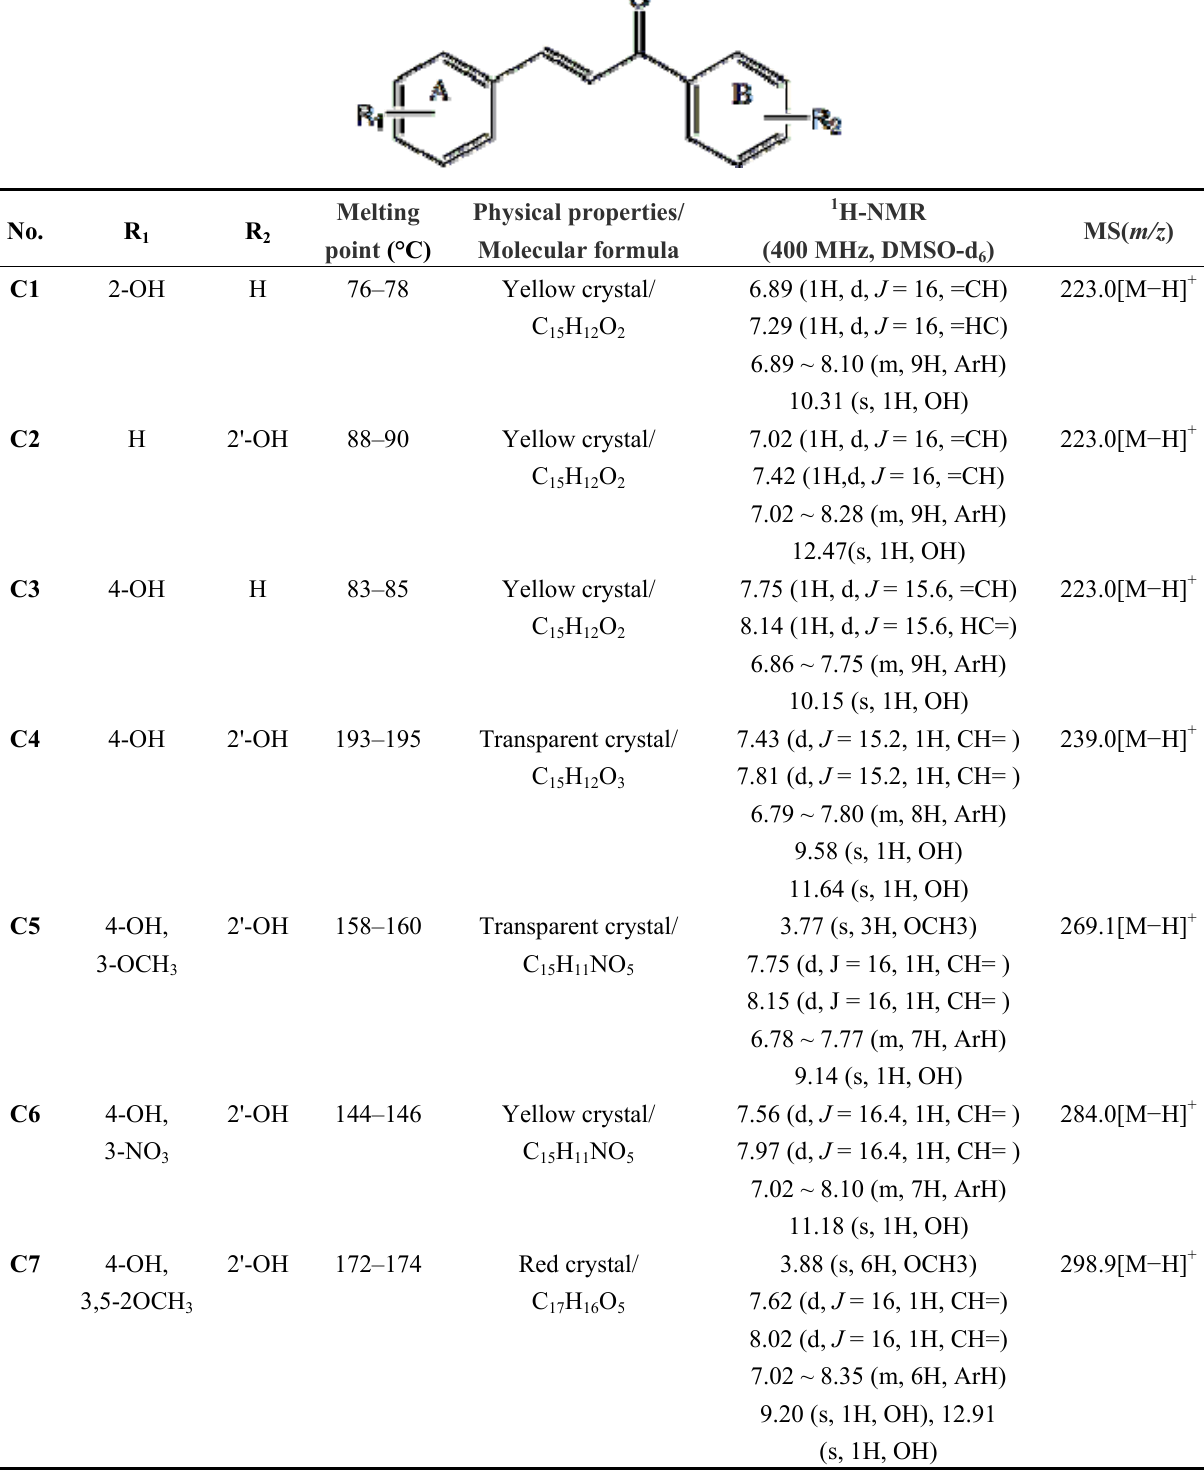
Table 1. Chemical structure, physical properties, 1 H-NMR and MS spectral data of the synthesized hydroxyl-substituted